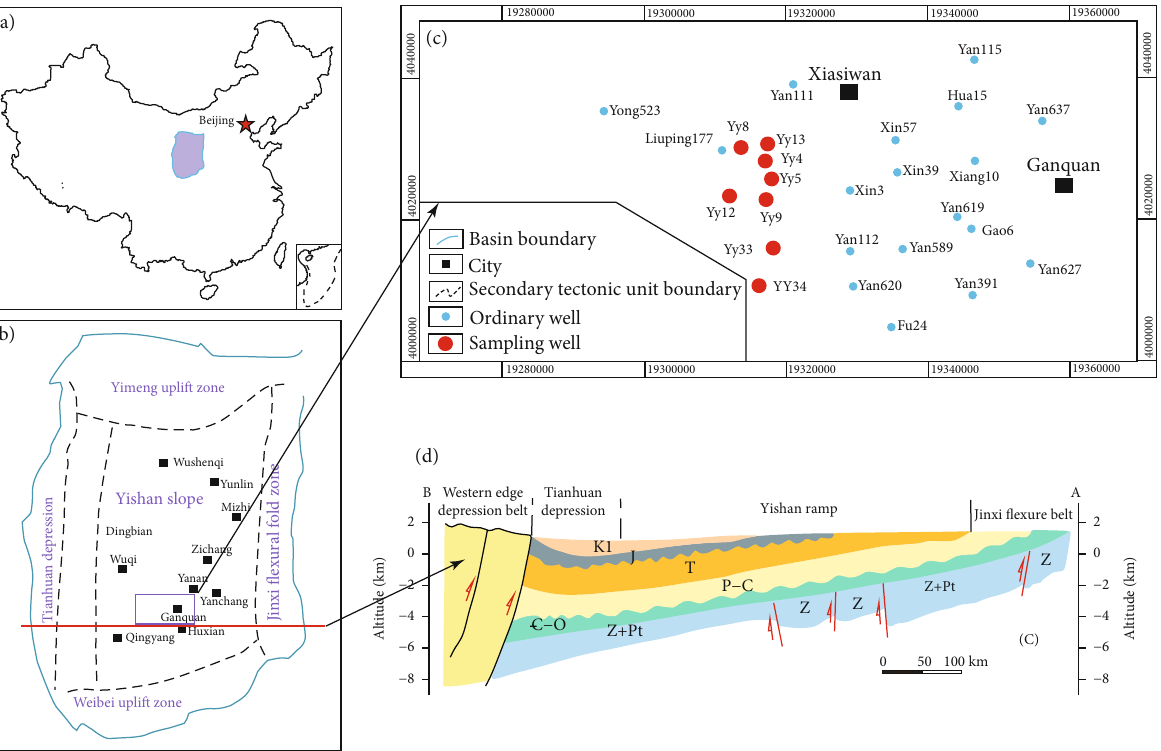
Figure 1: The location of the Ordos Basin in China (a and b) and the study area location of sampling wells (modi fi ed from Shan et al. [32]); stratigraphic column of the study